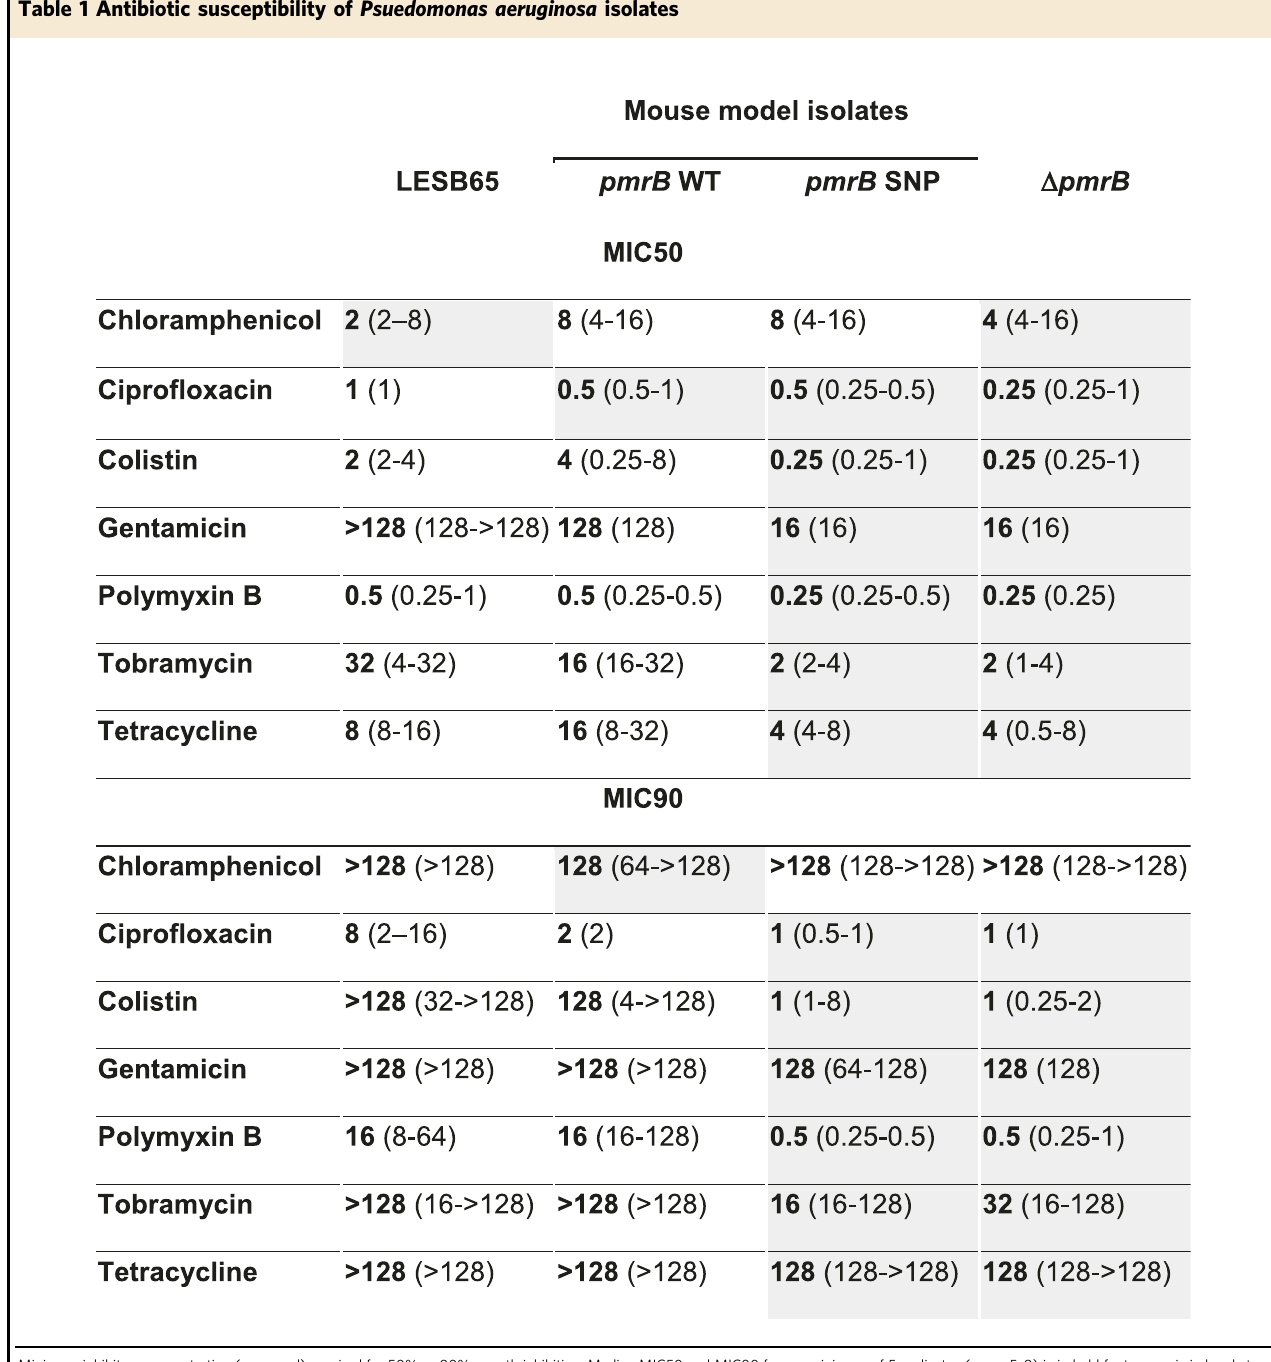
Table 1 Antibiotic susceptibility of Psuedomonas aeruginosa